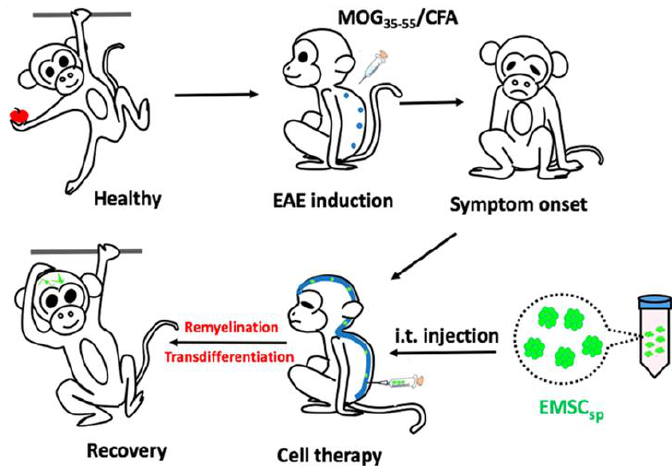
ff ect of hESC-MSC SP in experimental